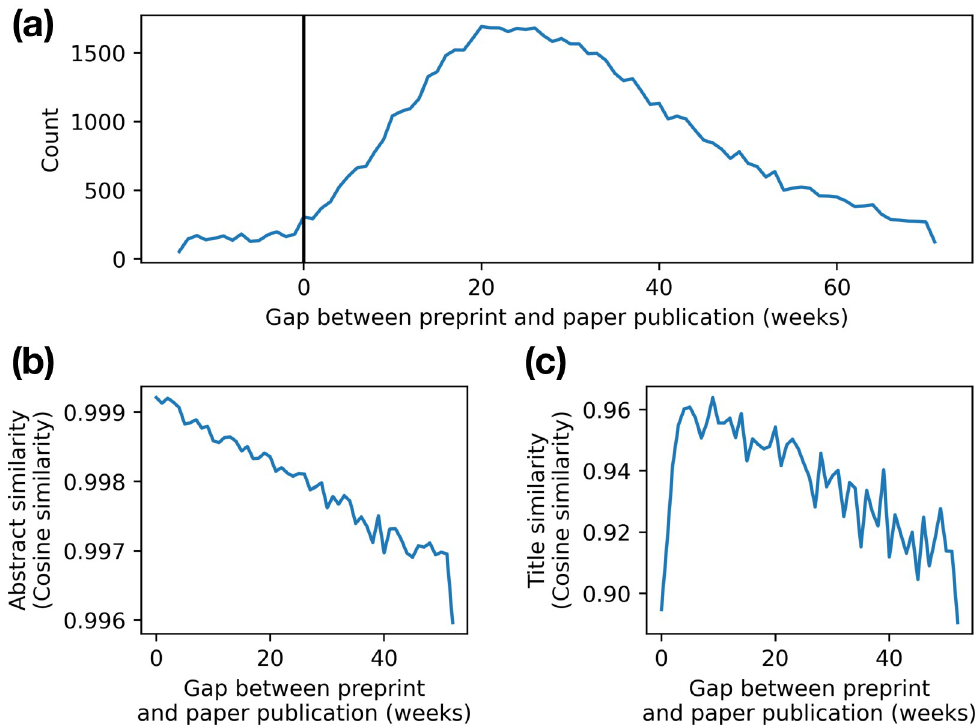
Fig 3. Effect of time between preprint and paper publication. (a) Histogram of the time gap between preprint posting and paper publication in weeks. (b) Median abstract similarity, as measured with cosine similarity, between preprint and paper over time. (c) Mean title similarity, as measured with cosine similarity, between preprint and paper over time.